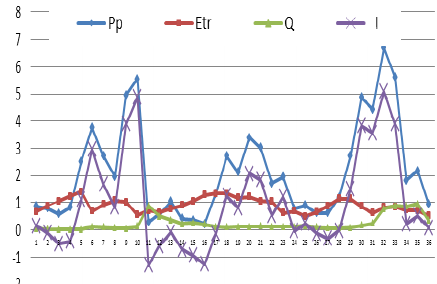
Figure 2. Monthly Accumulated values (km3) from San Pedro catchment. Precipitation (Pp), actual evapotranspiration (Etr), Runnoff (Q) and ΔI (Pp - [ETr + Q]) difference, of three years of analysis 2008 (months 1 a12), 2009 (months 13 to 24) and 2010 (months 25 to 36)